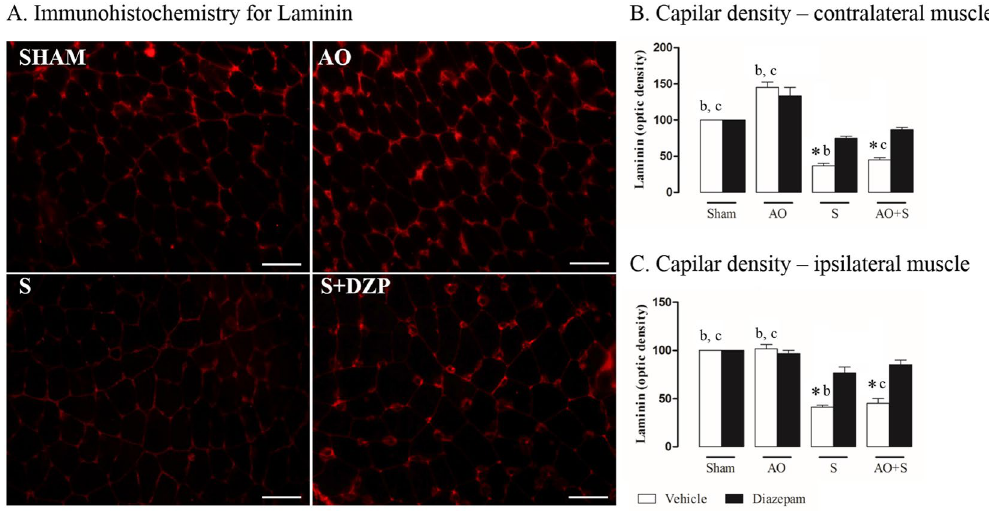
Figure 4. Effects of stress, occlusal instability and diazepam treatment on muscle capillary pattern. ( A ) Panels show representative photomicrographs of immunofluorescence for capillary marked by laminin in the right MPM of control rats (SHAM) and rats submitted to Altered Occlusion (AO), chronic stress (S) or stressed group treated with diazepam (S + DZP), 40 × magnification. ( B ) Graphs indicate number of capillaries marked by laminin in control rats (Sham) and rats submitted to altered occlusion (AO), chronic stress (S) or both (AO + S) (n = 8 per group) in contralateral and ipsilateral muscles. Two-way ANOVA indicated an effect of stress and exodontia, isolated or associated. Data were expressed as mean ± SEM. SEM: standard error means. * P < 0.05 vs diazepam treatment; b P < 0.05 vs S + vehicle; c P < 0.05 vs AO + S + vehicle. SEM: standard error